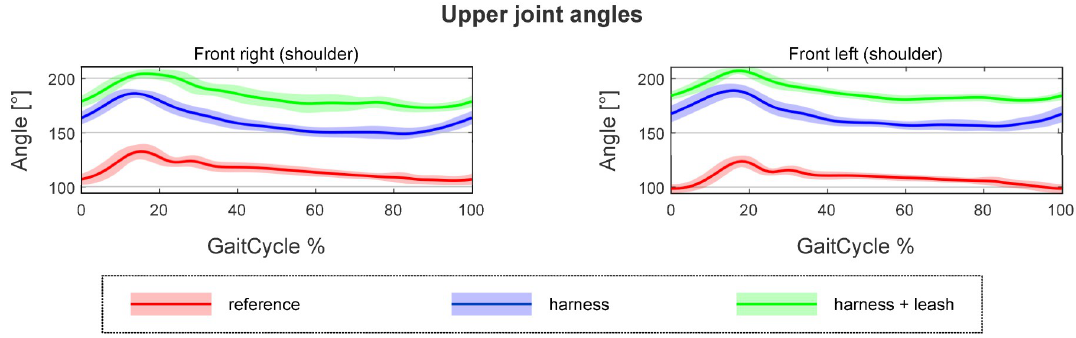
Fig 14. Offset in the shoulder angles in the case of dog 4